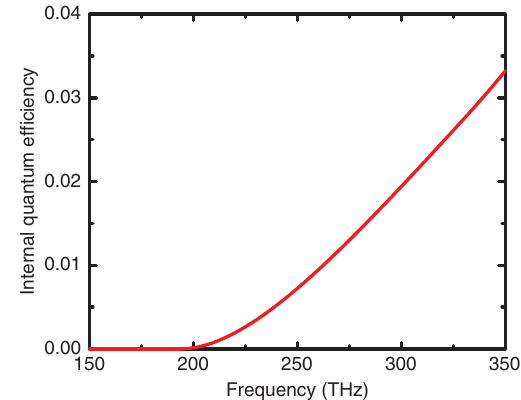
Figure 9: The internal quantum efficiency of hot-electron photodetection based on the PC-SCPA in our optical system possessing the phase coupling as a function of incident